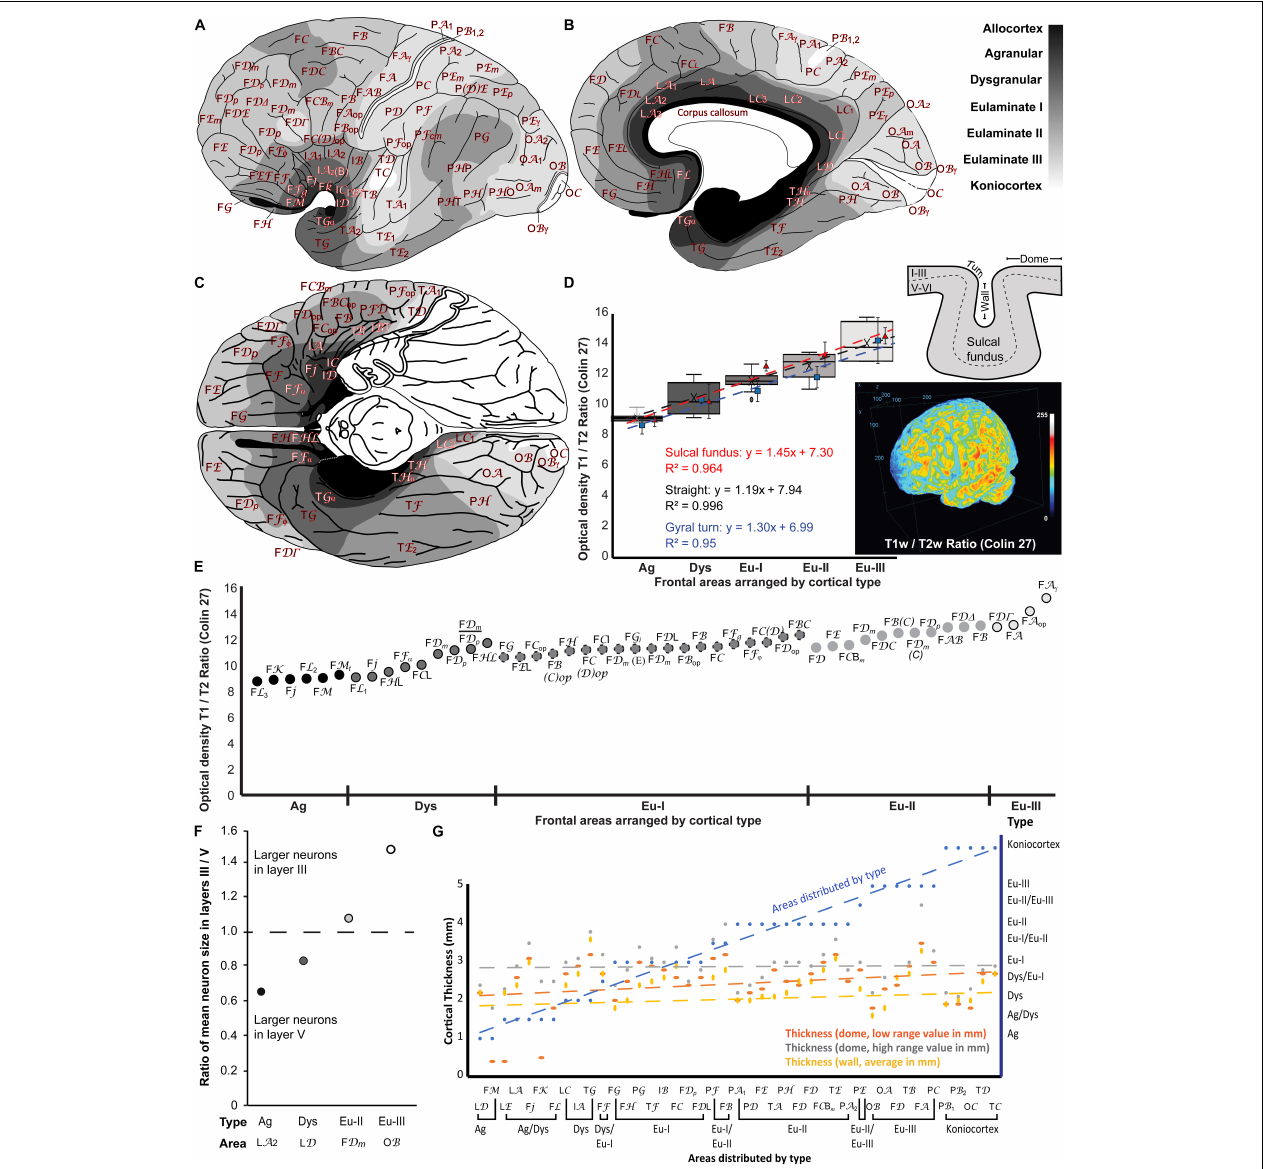
FIGURE 8 | Cortical types across the maps of the human cerebral cortex of the Atlas of von Economo and Koskinas (1925/2008) and comparison of cortical type maps with T1w/T2w MRI maps, size of pyramidal neurons in layers III and V, and cortical thickness. (A) , Lateral view of the hemisphere. (B) , Medial view of the hemisphere. (C) , Basal view of the brain; the temporal pole has been removed on the left hemisphere. In (A–C) frontal is to the left and occipital to the right. Cortical types are depicted in grayscale according to the analysis summarized in Tables 4–7 . The allocortex is colored black, Agranular areas are colored with the darkest gray, Dysgranular and Eulaminate areas are colored in progressively lighter grays and Konicortices are white. Cortical areas are indicated with the alphanumeric nomenclature of von Economo and Koskinas (1925/2008). (D) , Box plots of the mean optical density estimates measured at the straight parts (dome and gyral wall) of each cortical area shown in (E) . Estimates for each type include the Minimum (smallest value in a data set), First quartile (middle value between the Minimum and Median—25th percentile), Median (middle value of a data set), Third quartile (middle value between the Median and the Maximum—75th percentile), and Maximum (largest value in a data set). The black dotted line indicates the linear fit ( R 2 = 0.996) with a slope = 1.19. We also included measurements and the linear fits at the sulcal fundus (red dashed line), and gyral turning points (blue dashed line) of each cortical area. Three-dimensional projection of the T1w/T2w ratio of the Colin 27 dataset that was used for this analysis. (E) , Mean optical density estimates of representative cortical columns of all 47 frontal regions identified in the Atlas of the Human Cerebral Cortex of von Economo and Koskinas (1925/2008), color-coded in grayscale and grouped by respective cortical type, as presented in Tables 4 , 5 . The T1w/T2w ratio, which correlates to myelin content and cytoarchitecture, increases gradually from Agranular to Eulaminate frontal areas. (F) , Ratio of mean pyramidal neuron body size in layers III and V shows progressive increase of the size of neuron bodies of pyramidal neurons in layer III in parallel with laminar elaboration. Pyramids with the largest neuron bodies in granular area LA 2 and Dysgranular area LD are in layer V; in contrast, pyramids with the largest neuron bodies in Eulaminate II area FD m and Eulaminate III area OB are in layer III. (G) , Cortical thickness is not related to cortical type. The thickness of 43 cortical areas at the dome (orange dashed line: low range value; gray dashed line: high range value) and at the gyral wall (yellow dashed line) was obtained from von Economo (1927/2009). The 43 analyzed cortical areas are distributed according to cortical type (blue dashed line; see Tables 4–7 ). Ag, Agranular; Dys, Dysgranular; Eu-I, Eulaminate I; Eu-II, Eulaminate II; Eu-III, Eulaminate III. For the abbreviations of cortical areas (see Tables 4–7